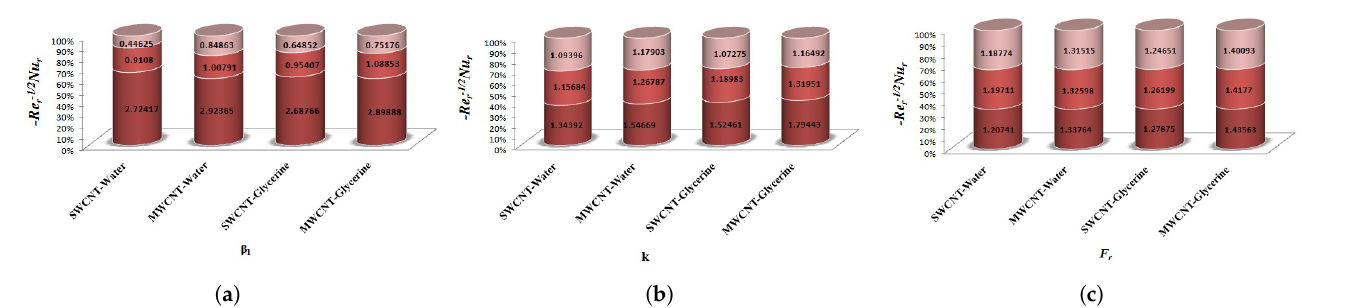
Figure 29. Impact of β 1 , k , F r on Nusselt number.